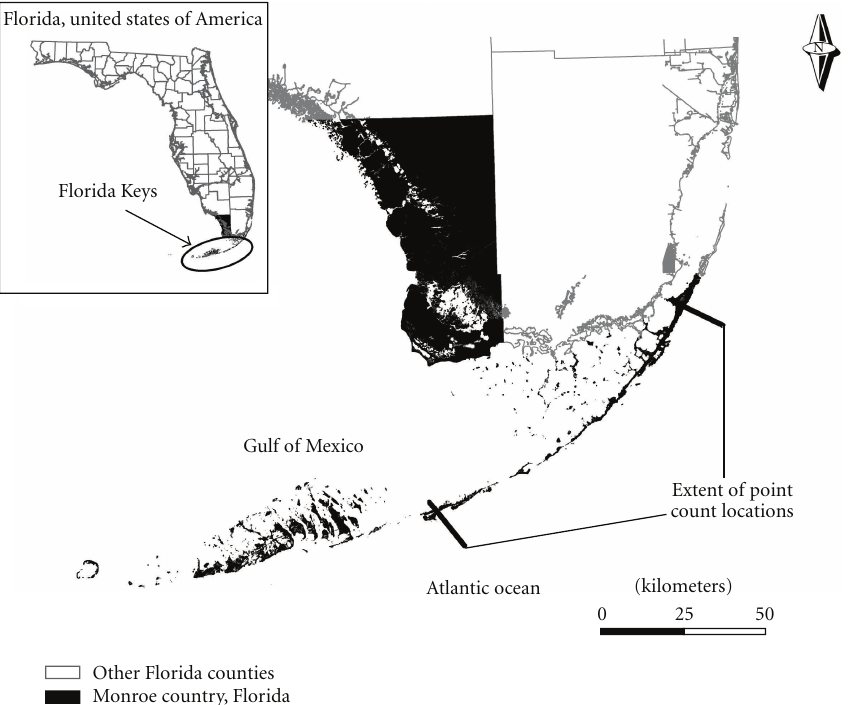
Figure 1: Florida Keys archipelago and study area located o ff the southern tip of Florida,